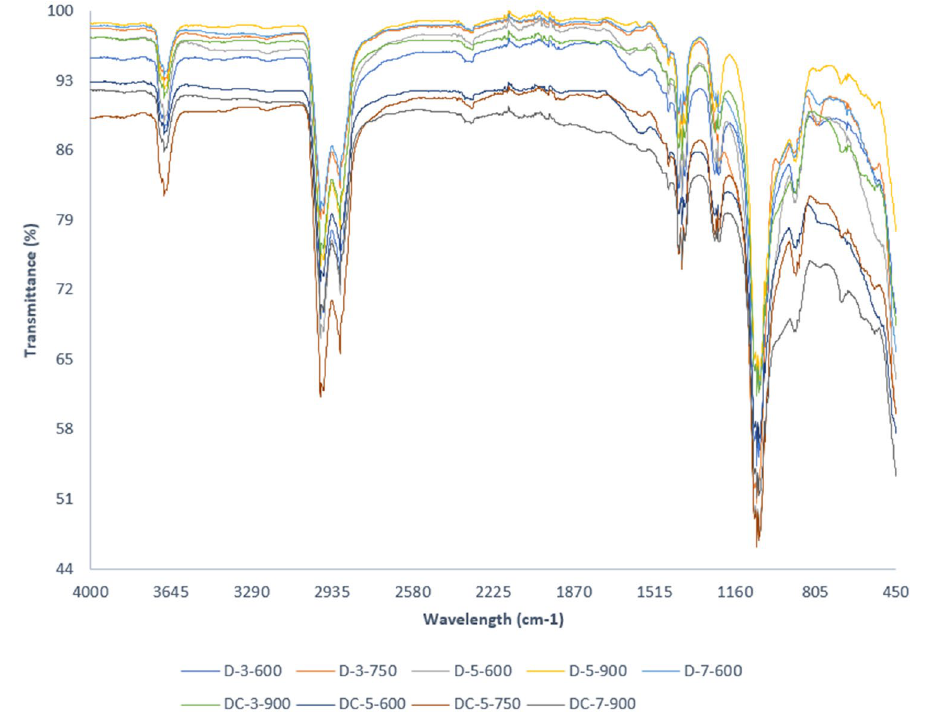
Figure 7. FT-IR spectra of SBAC obtained from raw sewage sludge D as precursor.